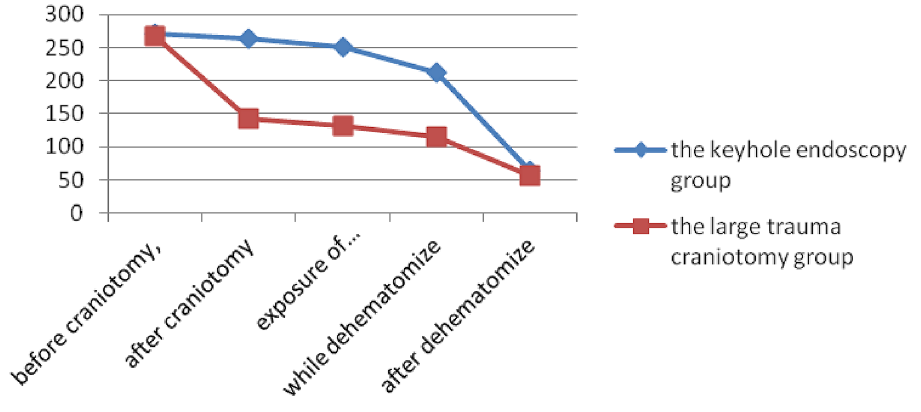
Figure 1. Change curves for